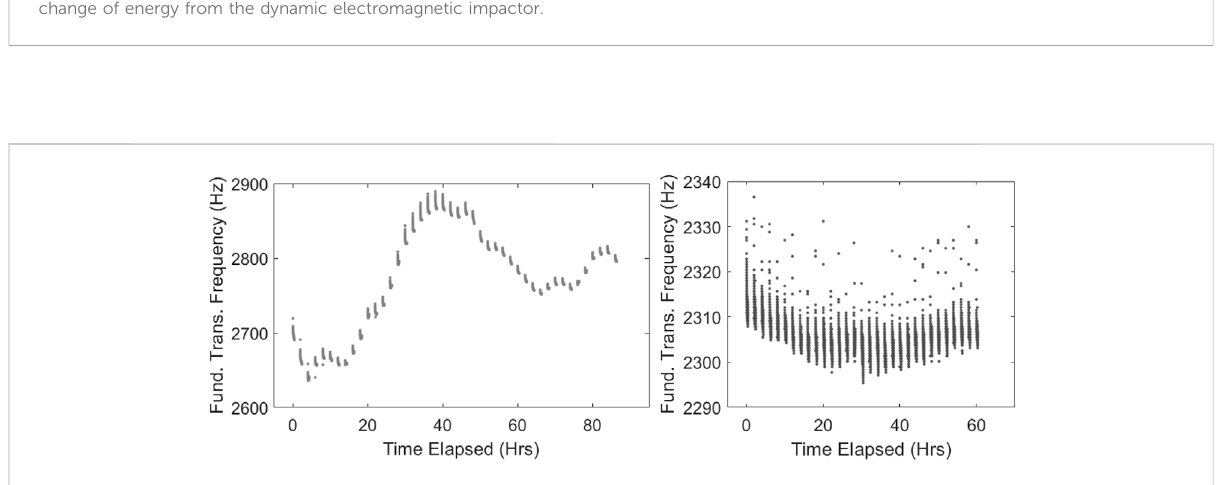
FIGURE 8 Sequential impact test sets carried out on neat cement pastes using a 2-h test cycle period in ambient laboratory conditions over the course of 5 days (left) and in a controlled temperature and relative humidity chamber (right).